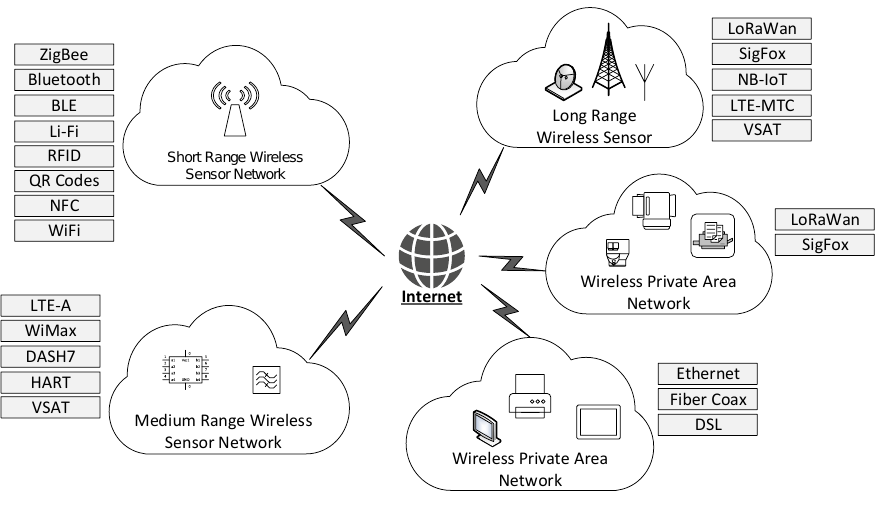
Figure 1. IoT system environment—applications and related access networks and